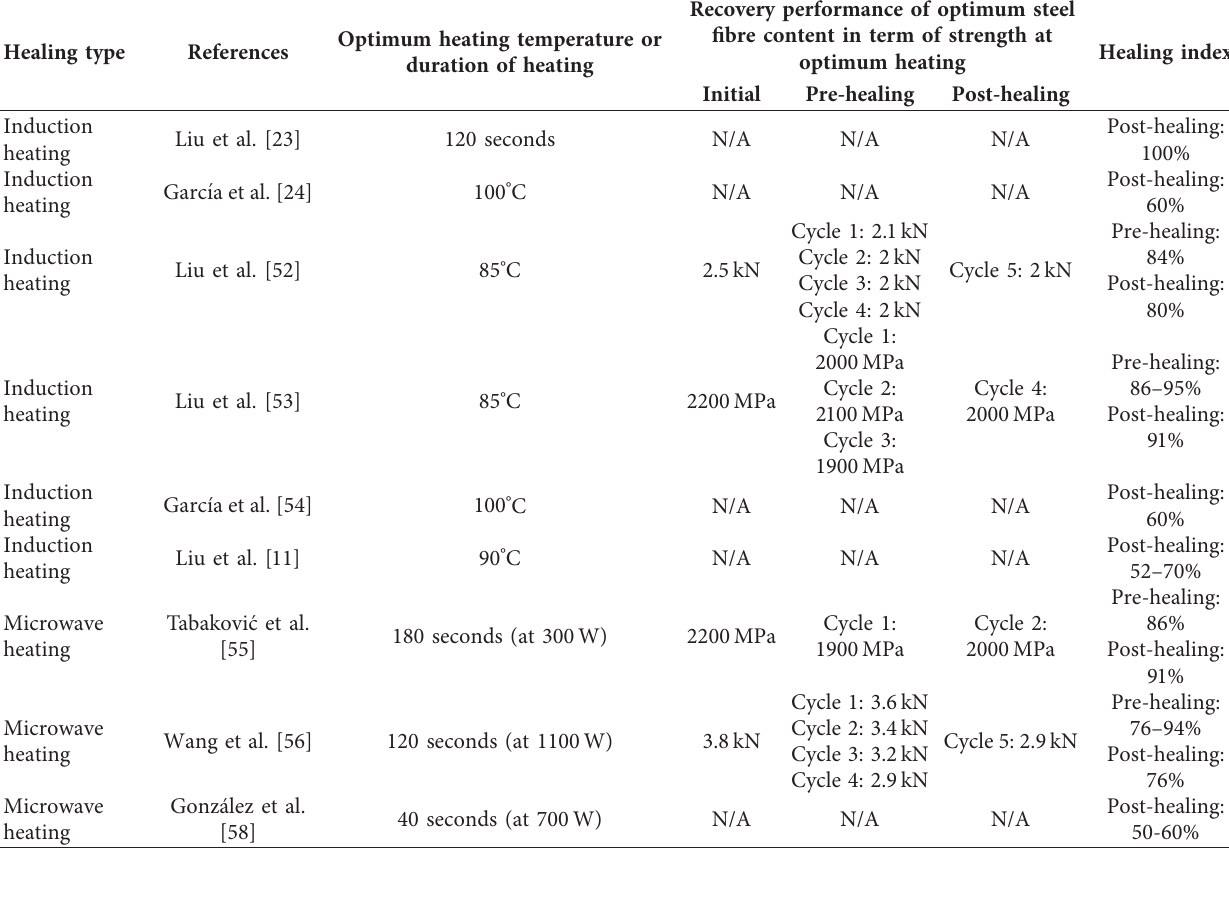
Table 3: Comparison of recovery performance between the microwave and induction heating system.